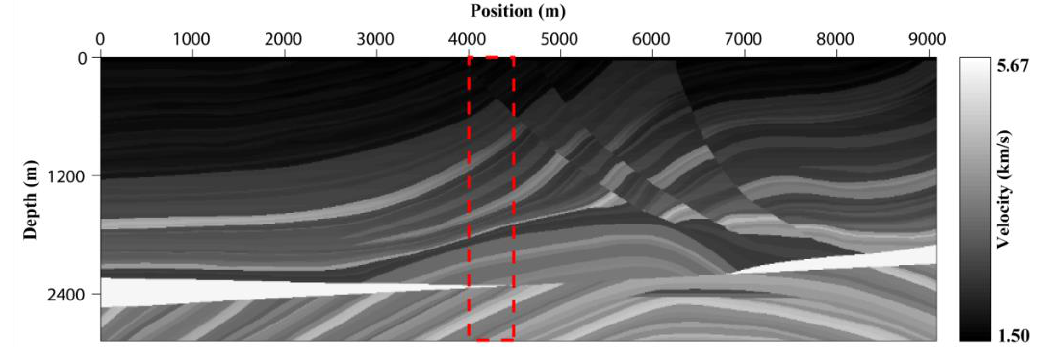
Figure 5. Marmousi velocity model.